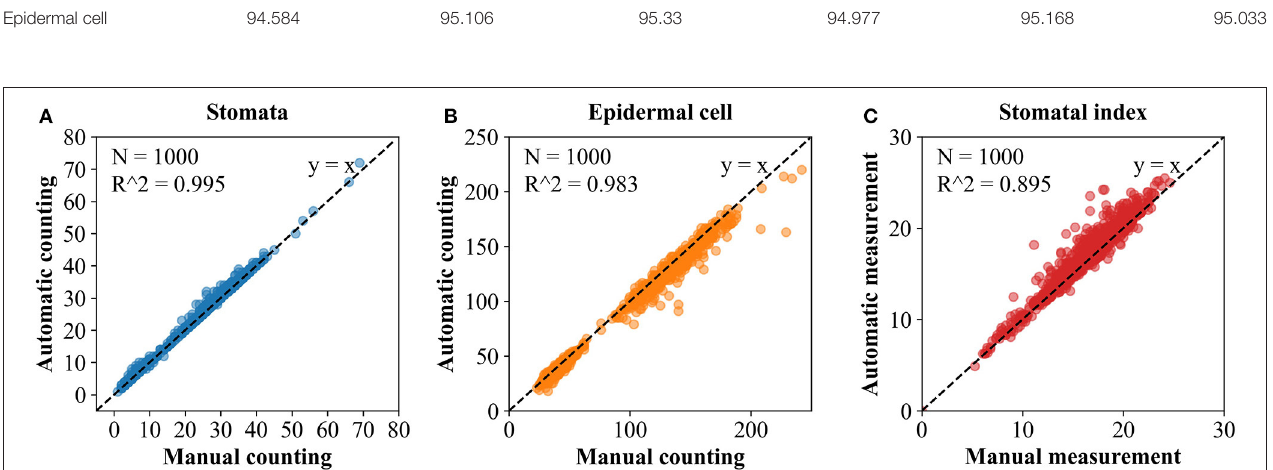
FIGURE 8 | Simple linear regression between the manual and automatic measurement. (A) Stomata. (B) Epidermal cell. (C) Stomatal index.